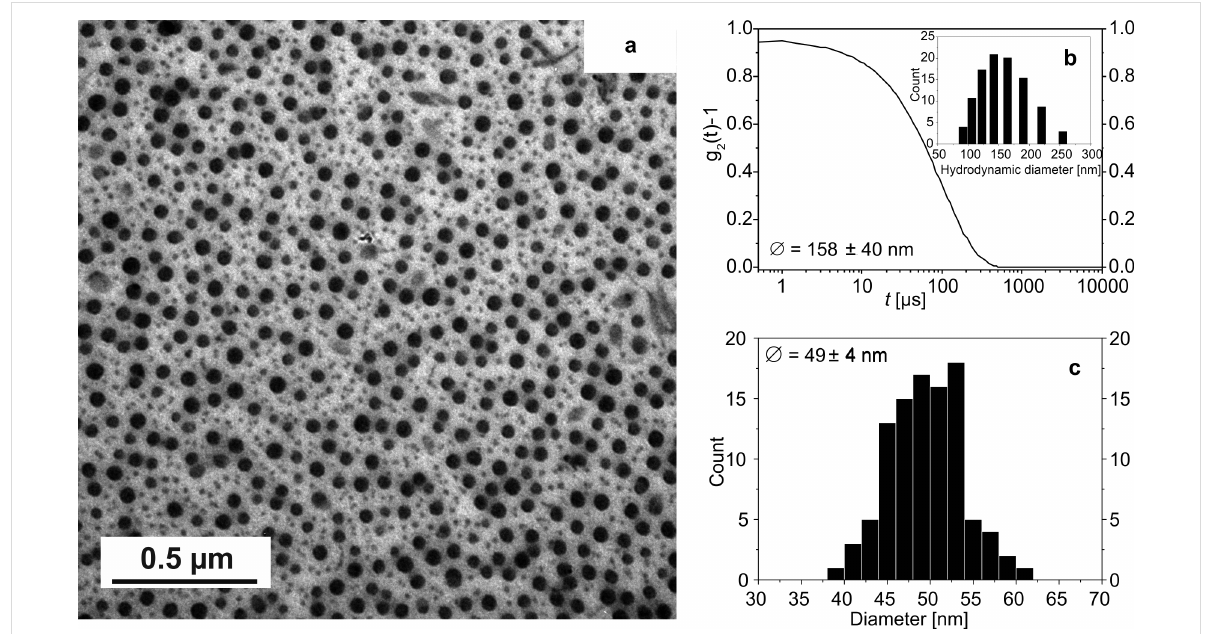
Figure 2: Characterisation of CP–BCP composite micelles. a) TEM picture of 3e ([FeL eq (bpey)] n @BCP, five cycles) illustrating the core–shell nature of the particles. b) Autocorrelation function from dynamic light scattering of 3e in THF (43 wt %) with size histogram. c) Size histogram of the core from the TEM picture given in panel a).